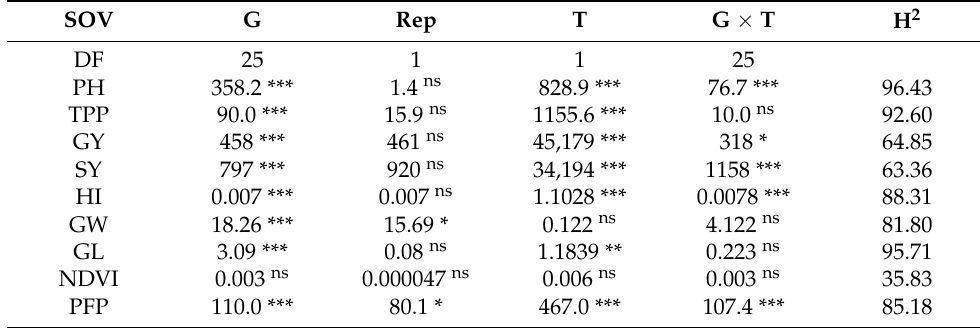
Figure 4. Pollen fertility test in 22 GSR lines and four control variants of rice. Viable pollens were stained deep brown color, while the sterile pollens were slightly or not stained (bars = 100 µm). Table 1. Mean square values of morpho-physiological